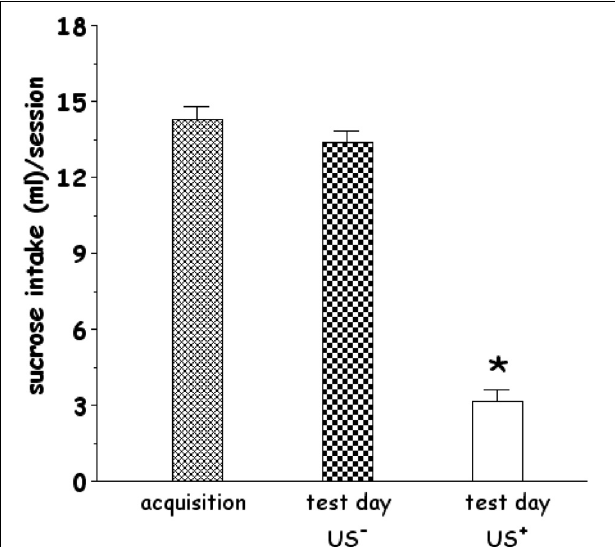
FIGURE 1 | Effect of systemic administration of lithium chloride (LiCl, 125mg/kg i.p., CS + , or saline i.p., CS − ) on average sucrose intake. CS + or CS − were administered 1h after the 20min drinking session of the last training day (acquisition). Each histogram ( n = 13 in each group) represents the average + s.e.m. of sucrose solution intake (ml) in 20min. ∗ p < 0 . 05 vs. US − (One-Way ANOVA followed by LSD post-hoc